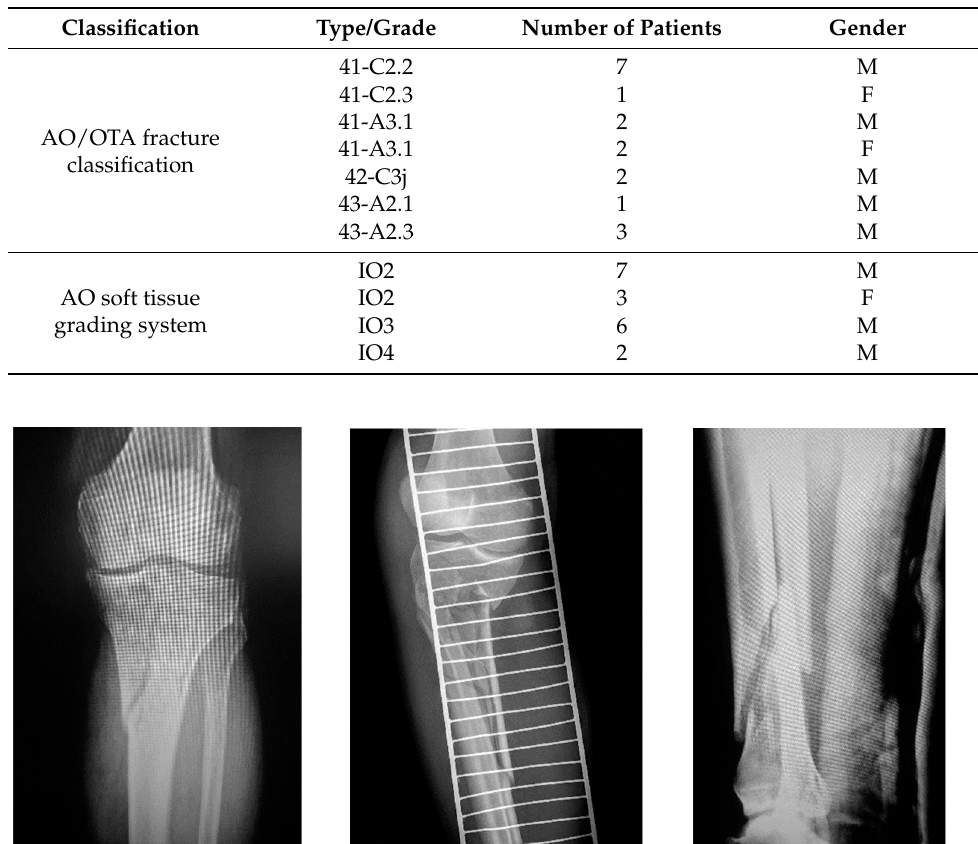
Figure 1. Preoperative radiographs of patients with an AO/OTA 41-C2.2 proximal tibial fracture with simple intra-articular involvement of both tibial condyles without intra-articular comminution and impaction ( left ), a 41-A3.1 multi-fragmentary proximal tibial extra-articular fracture ( middle ), or a 43-A2.3 distal tibial multi-fragmentary meta-diaphyseal fracture ( right ), all accompanied by significant soft tissue injury.